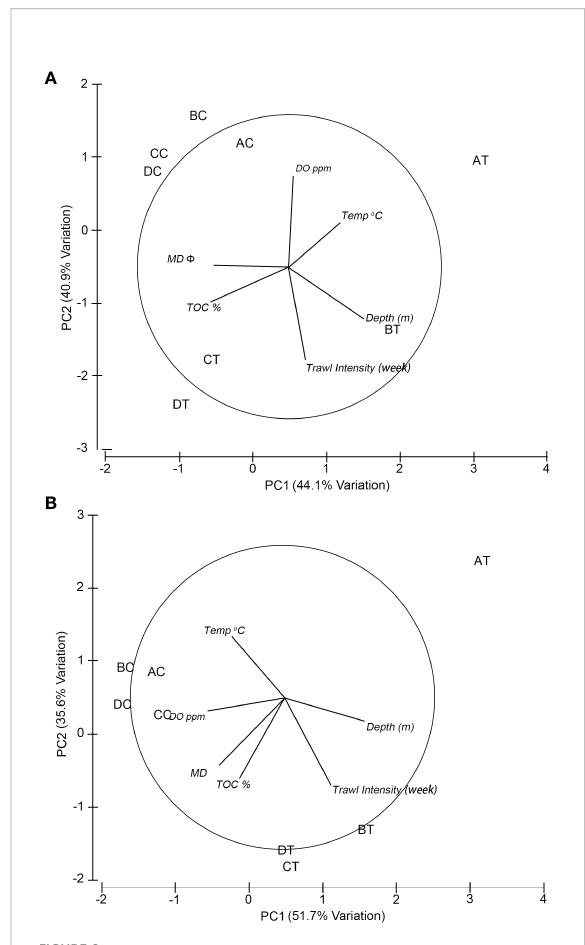
FIGURE 2 Principal component analysis (PCA) of normalised environmental factors using Euclidean distance for (A) summer and (B) winter. The lines show the direction of the environmental factors that are related to the sampling sites. AT-DT, trawling sites; AC-DC, non-trawled sites; Temp, temperature; DO, dissolved oxygen; TOC, total organic carbon; MD F , median sediment diameter in F scale (see Table